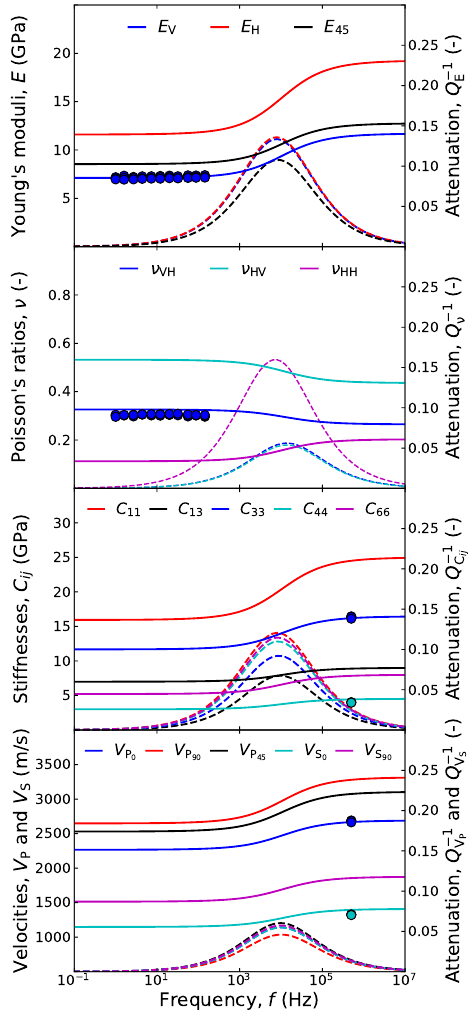
Figure 11. Young’s moduli ( E V , E H , and E 45 ), Poisson’s ratios ( ν VH , ν HV , and ν HH ), stiffnesses ( C 11 , C 13 , C 33 , C 44 , and C 66 ), and P- and S-wave velocities ( V P f . Circles are measurements. Solid (dispersion) and dashed (attenuation) are